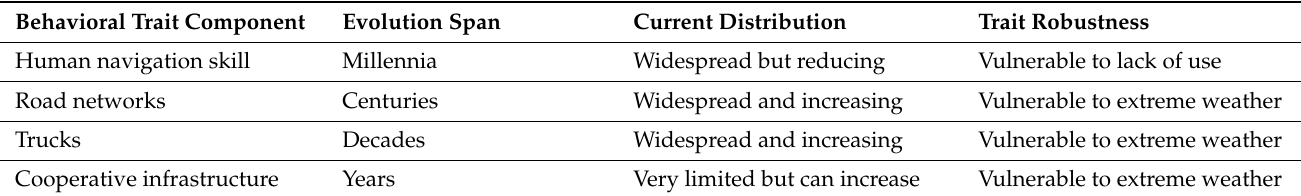
Table 2. Phylogeny: Interrelationships between trait components and trait